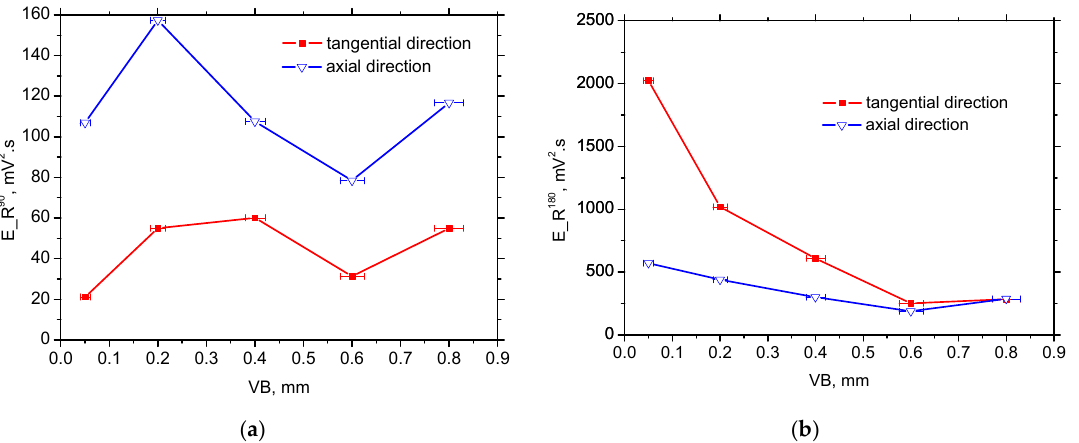
Figure 17. E_R 90 and E_R 180 along with VB: ( a ) E_R 90 —60.3 mV 2 ·s for HT, and ( b ) E_R 180 —272 mV 2 ·s for HT.